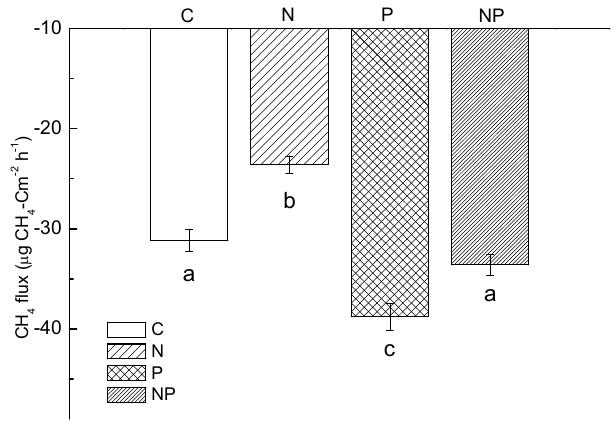
Figure 3 Comparisons of mean soil CH 4 fluxes between treatments from 2007 to Fig. 3. Comparisons of mean soil CH 4 fluxes between treatments 2009 after N and P additions. Bars indicate ± 1 SE, N = 5. Different letters denote from 2007 to 2009 after N and P additions. Bars indicate ± 1SE, N=5. Different letters denote significant difference ( p < 0 . 05) be- significant difference ( p < 0.05) between treatments by the Repeated Measurement tween treatments by the Repeated Measurement ANOVA. ANOVA.